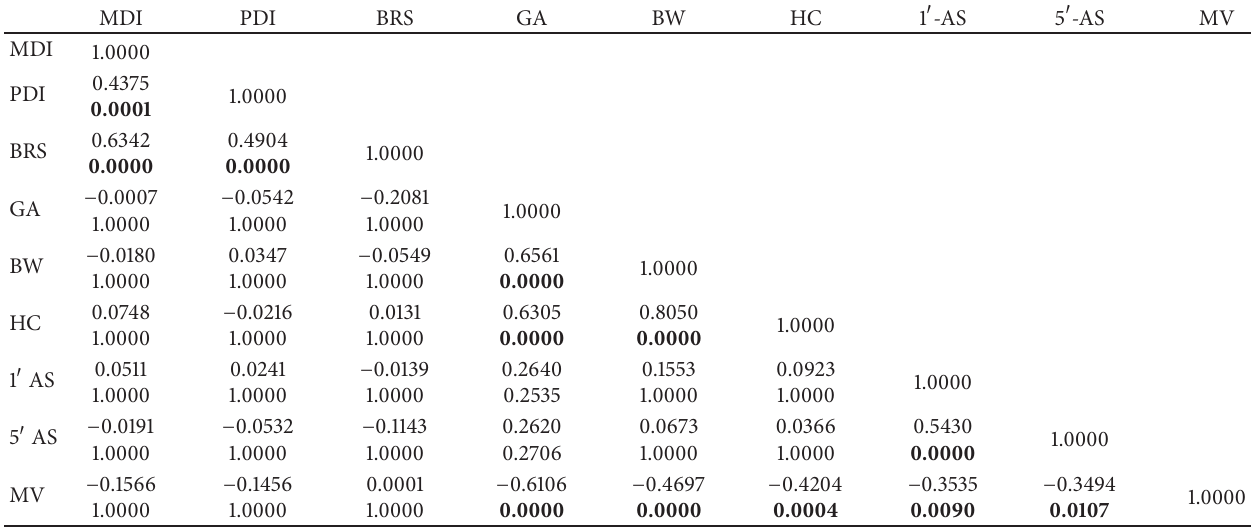
Table 3: Mutual relationships between observed clinical variables (quantitative variables) and outcome